Question: Write a caption explaining this figure to a reader.
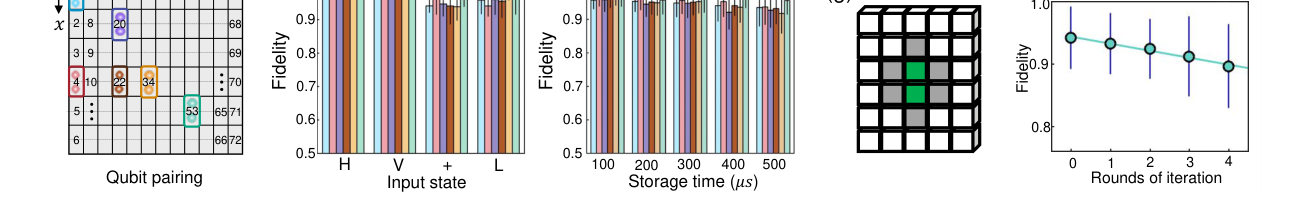
Answer: Performance of individual memory units. (a),(b), Coherence time and storage efficiency of the 144 micro-ensembles. (c), The storage and retrieval of an arbitrary polarization qubit. We first convert a polarization qubit a|H⟩+ b|V ⟩= cos(θ)|H⟩+ eiϕsin(θ)|V ⟩to a time-bin qubit with an encoding converter. Then the time-bin qubit is further converted into a path qubit to be stored in two memory cells and finally read out and converted back into a polarization qubit a4|H⟩+ b4|V ⟩= cos(θ4)|H⟩+ eiϕ4sin(θ4)|V ⟩, which has a high overlap fidelity with the input state if θ4 = θ and ϕ4 = ϕ. This can be achieved by calibrating the amplitude and phase in the read-out AODs. (d), The index of the 72 qubit cells paired from 144 micro-ensembles. (e)-(f), State fidelity of the retrieved qubit in six typical qubit cells 1, 4, 20, 22, 34 and 53. Fidelities for different input polarizations with 15µs storage are in (e), and average fidelities over 4 polarizations at different storage time are in (